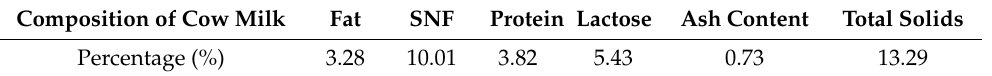
Table 1. Composition of Holstein milk. Composition of Cow